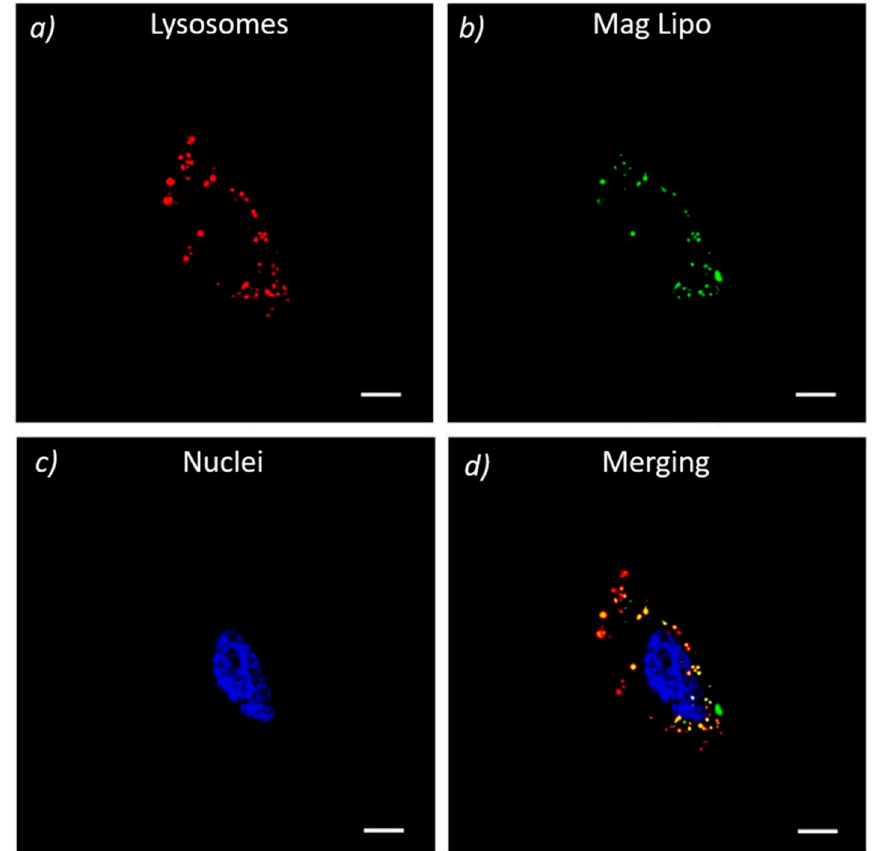
Figure 7. In vitro cell internalization of MagLipo in static conditions. Confocal fluorescence images of HepG2 cells showing MagLipo (in green) up-take and co-localization (in yellow) with lysosomes (in red) after LysoTracker assay; nuclei are stained in blue (All scale bars = 10 µm).